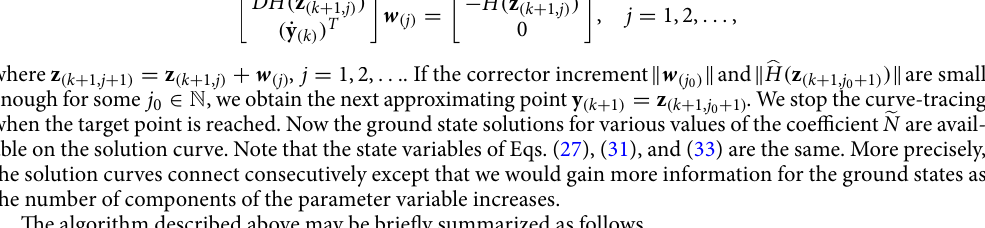
Algorithm 3.2 A multi-level continuation method for rapidly rotating spin-1 BEC.